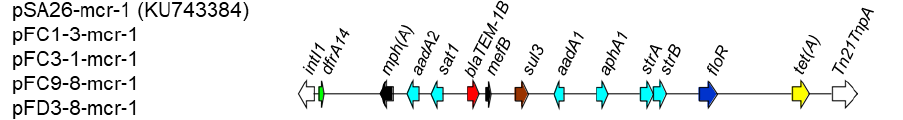
Figure 3. The resistance island of the IncHI2 plasmids of this study and that of pSA26-mcr-1 (of a human isolates described in [14]).